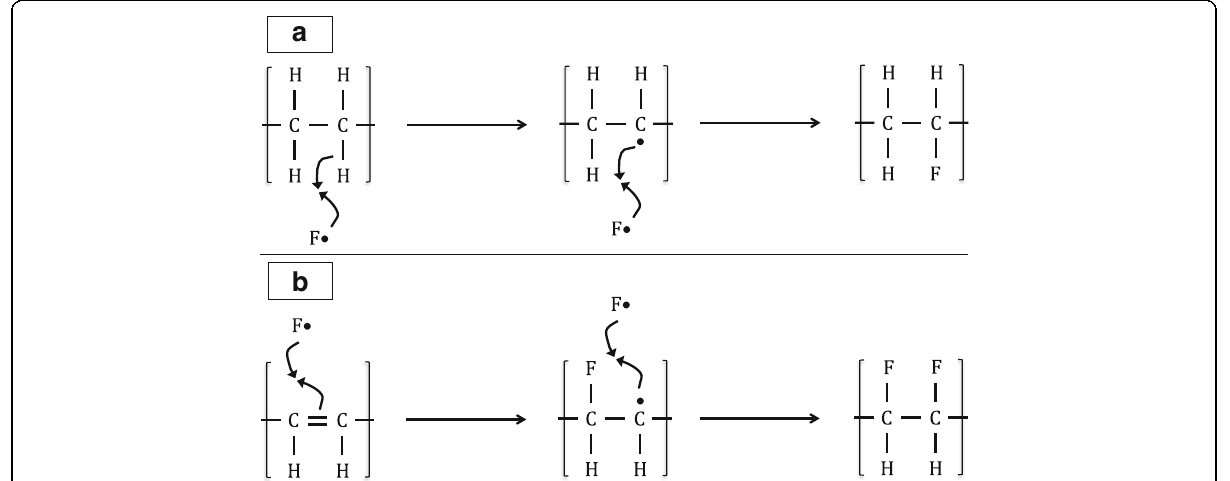
Fig. 4 Surface fluorination suggested pathways for ( a ) saturated and ( b ) unsaturated